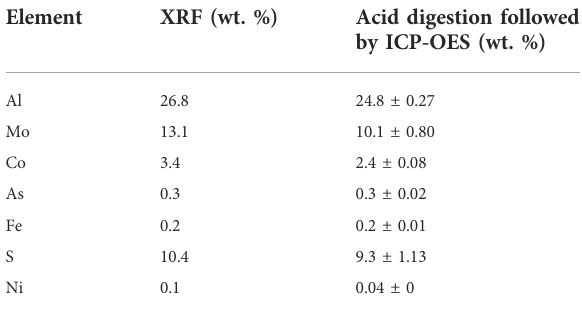
TABLE 1 Elemental composition of the as-received spent catalyst determined by XRF or acid digestion followed by ICP-OES analysis.